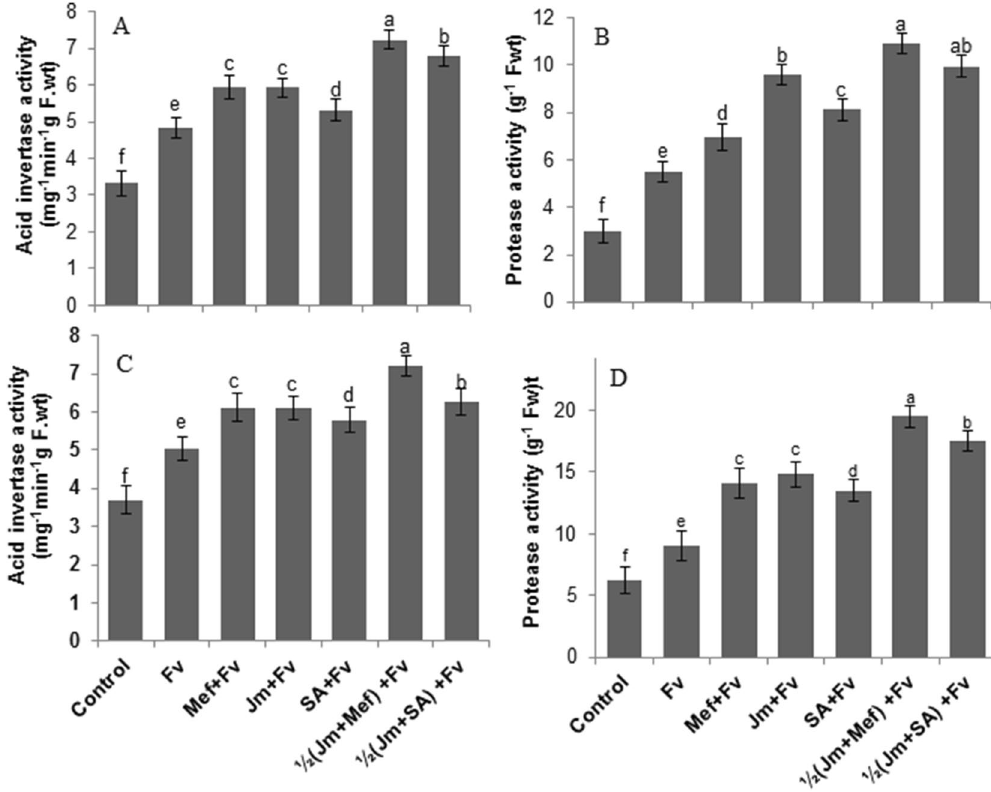
Figure 6. Effect of seed treatments with J. mimosifolia extract and control formulations on AI and protease activities of maize leaves from plants inoculated with F. verticillioides (21 d after inoculation). ( A ) AI activity (pot experiment), ( B ) Protease activity (pot experiment), ( C ) AI activity (field experiment), ( D ) Protease activity (field experiment). Data expressed as ± standard deviation of mean (SD) of three replicates. Mean values with different letters are significantly different from each other according to the least significant difference ( LSD ) at P < 0.05. See Table 1 for